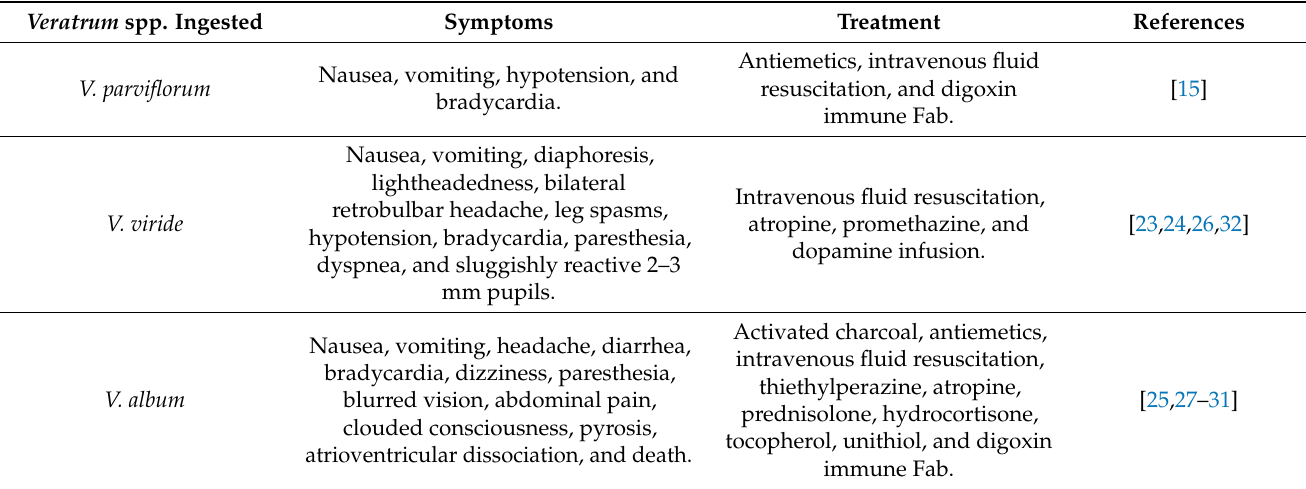
Table 2. A summary of several cases of Veratrum poisoning, including the causative plant, symptoms, and